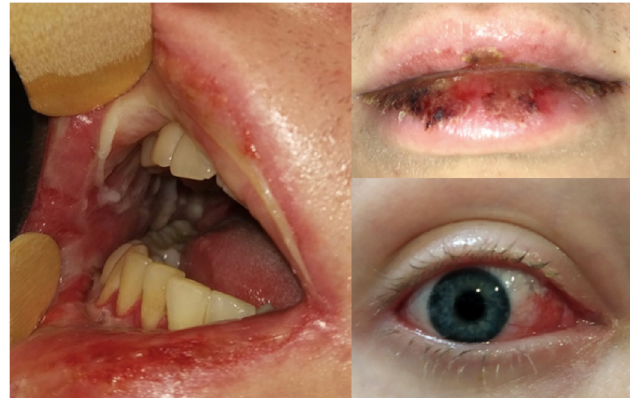
Fig. 1. View of different lesions.